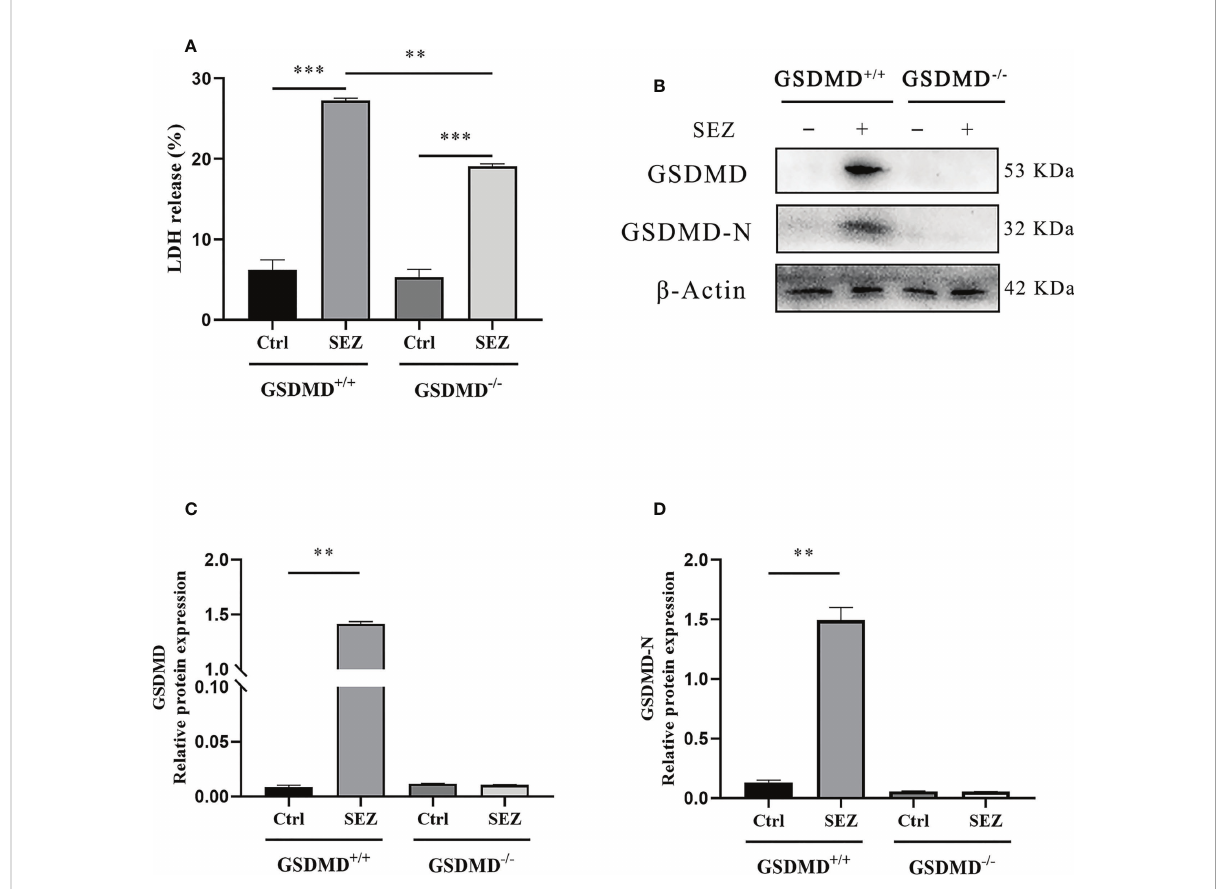
FIGURE 5 LDH release and expression of GSDMD-N in peritoneal macrophages are promoted after SEZ infection. (A) The release of LDH in culture supernatants was measured using an LDH cytotoxicity assay kit. (B) GSDMD and GSDMD-N proteins in GSDMD +/+ or GSDMD -/- macrophages were performed by Western blotting. (C, D) The relative intensities are expressed as the ratio of relative proteins to b -Actin. These experiments were conducted with 3 replicates. One representative experiment of three (B) is shown. Data are expressed as mean ± SD. ** p <0.01, *** p <0.001, one-way ANOVA (A)